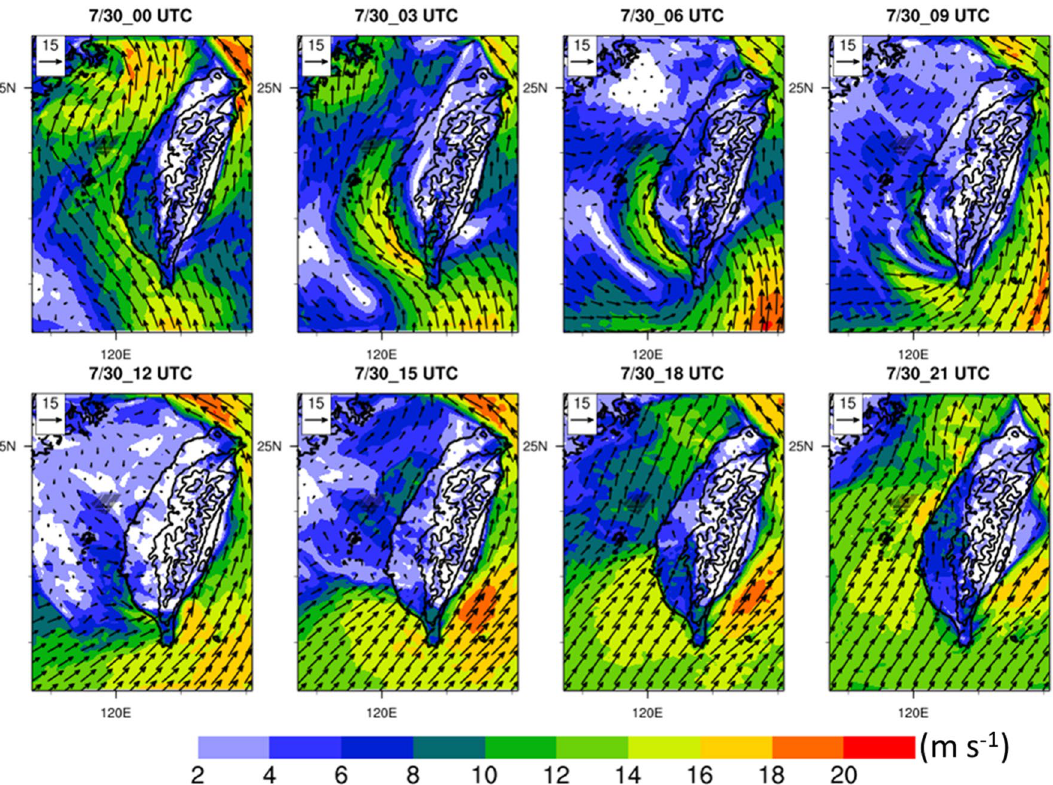
Figure 3. Hub-height (110 m) horizontal wind speed (shaded, m s −1 ) and horizontal wind (vector, m s −1 ) in the WRF model domain 2 (resolution is 2 km) during 00:00–21:00 UTC on July 30, 2017. The black contour lines indicate the elevation of Taiwan (m). The contour interval is 1000 m from 500 to 3500 m. Maps and plots were produced using NCAR Command Language (NCL) version 6.6.2 37